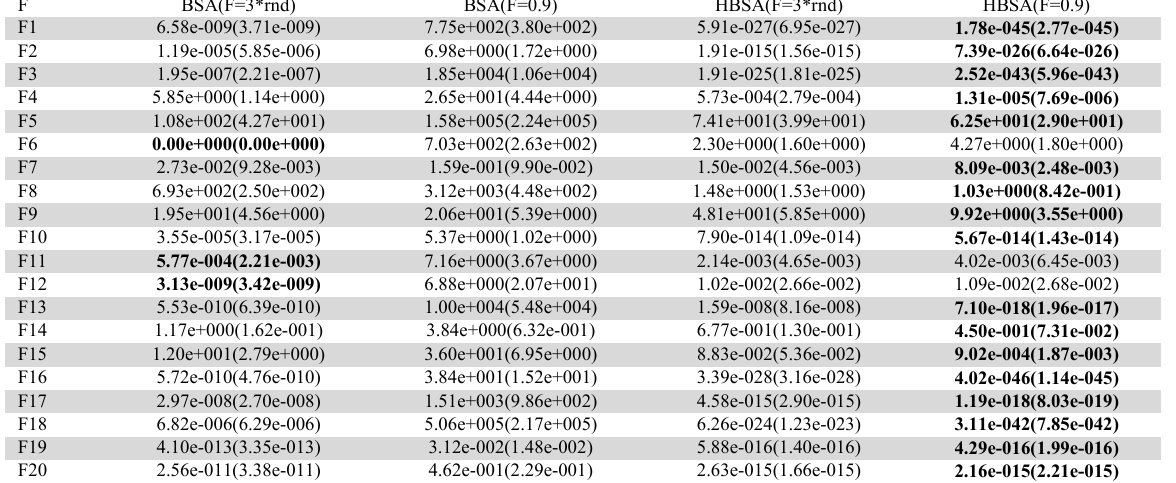
Comparison of statistical result of error function value with BSA (For different value of control parameter) F